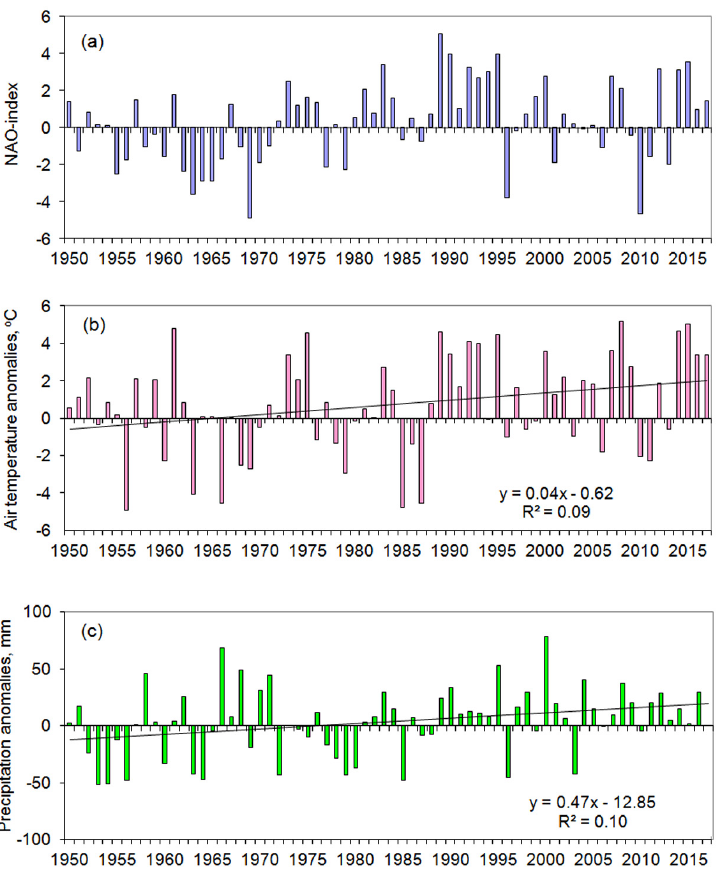
Figure 2. ( a ) North Atlantic Oscillation (NAO)-index and anomalies of average air temperature ( b ) and precipitation ( c ) for December-March for period 1950–2017 relative to the climate norm (period 1961–1990) for meteorological station Petrozavodsk. Solid lines are linear